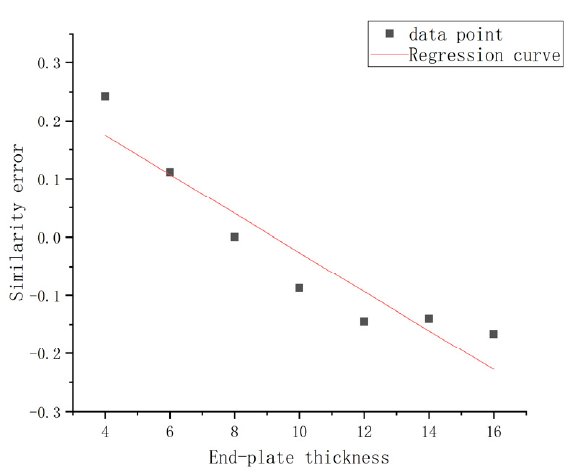
Figure 27. Data points and the regression curve at C p .